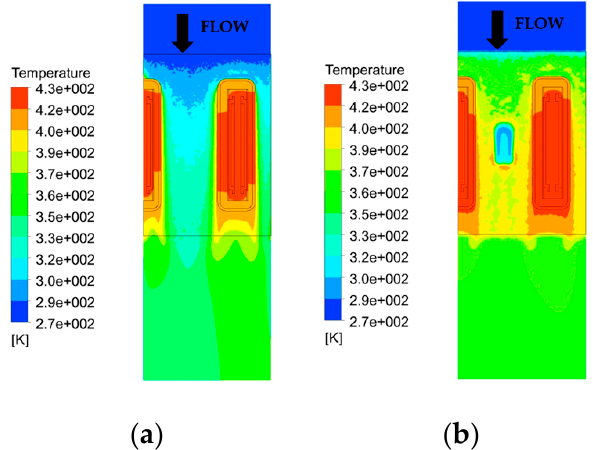
Figure 10. Temperature distribution of PTC heater. ( a ) Case 1; ( b ) Case 4.